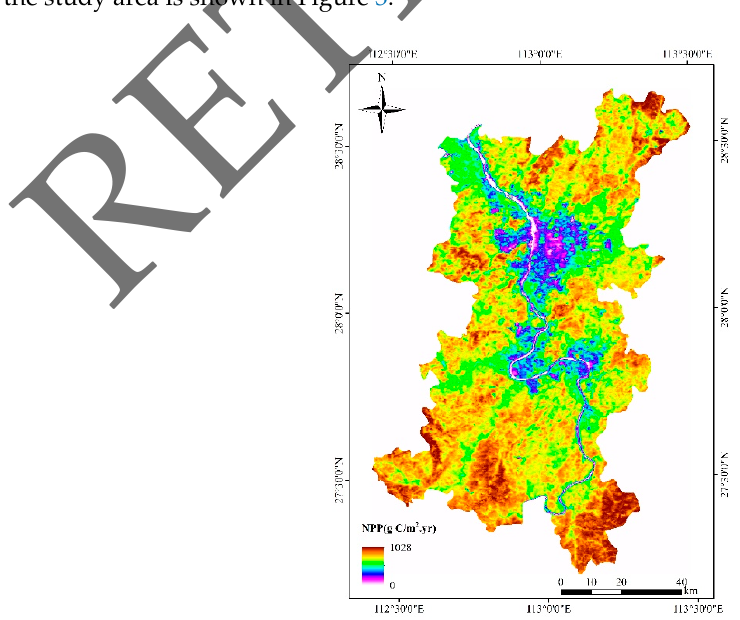
Figure 3. MOD17A3H data of the study area.